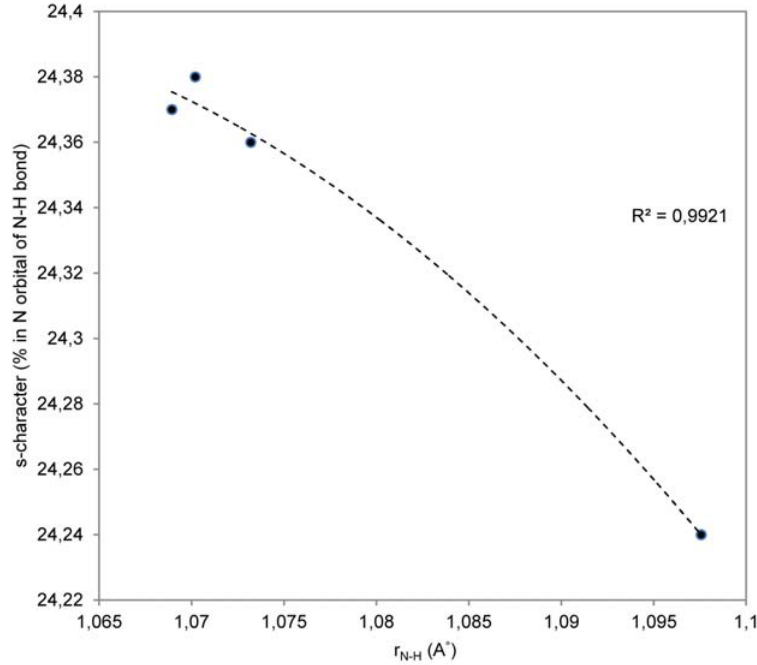
Figure 6. correlation between s-character and N-H bond length for N-H–Cl interaction in alanine hydrochloride